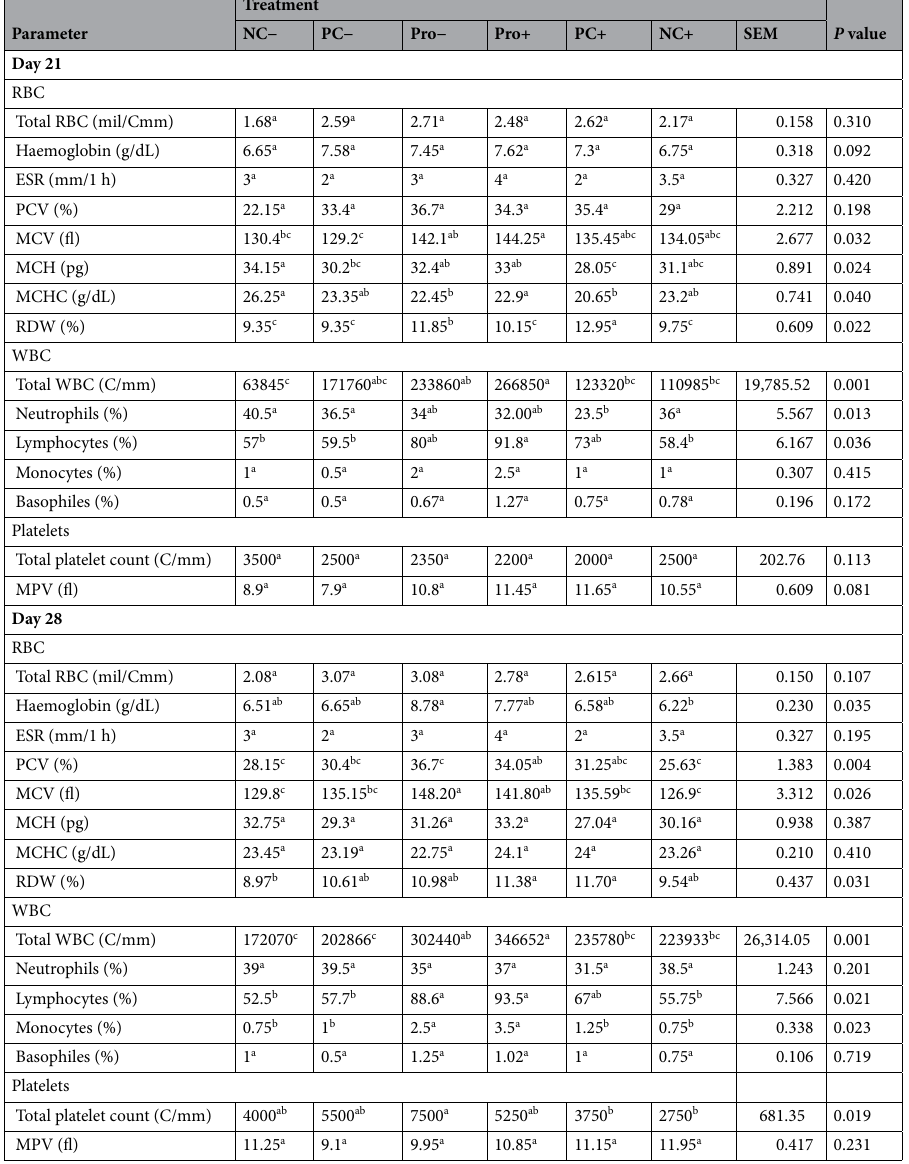
Table 7. Effects of probiotics supplementation on haematological parameters of Pasteurella multocida challenged broiler chickens. Values are means of two replicates and standard errors of means. Within each variable, values with the same superscript letter are not significantly different according to Duncan’s multiple range test (P > 0.05). NC−: unchallenged negative control; PC−: unchallenged positive control; Pro−: unchallenged probiotics control; Pro+: challenged probiotic control; PC+: challenged positive control; NC+: challenged negative control. MPV mean platelets volume, MVC mean corpuscular volume, MCH mean corpuscular haemoglobin, MCHC mean corpuscular haemoglobin concentration, RDW RBC distribution width, ESR erythrocyte sedimentation